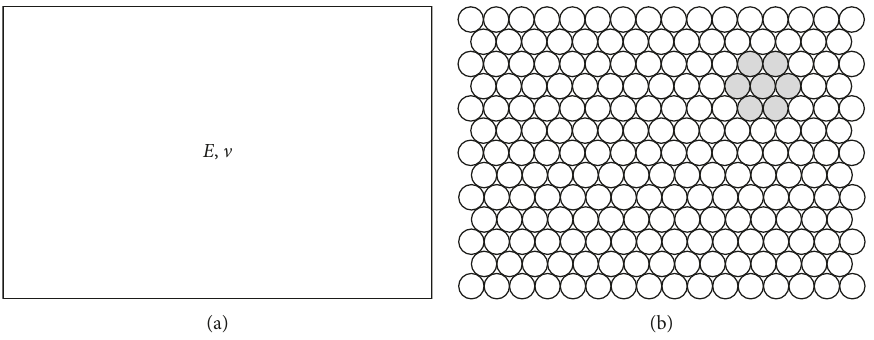
Figure 1: Equivalent (a) continuous and (b) discrete media (close-packed assembly).